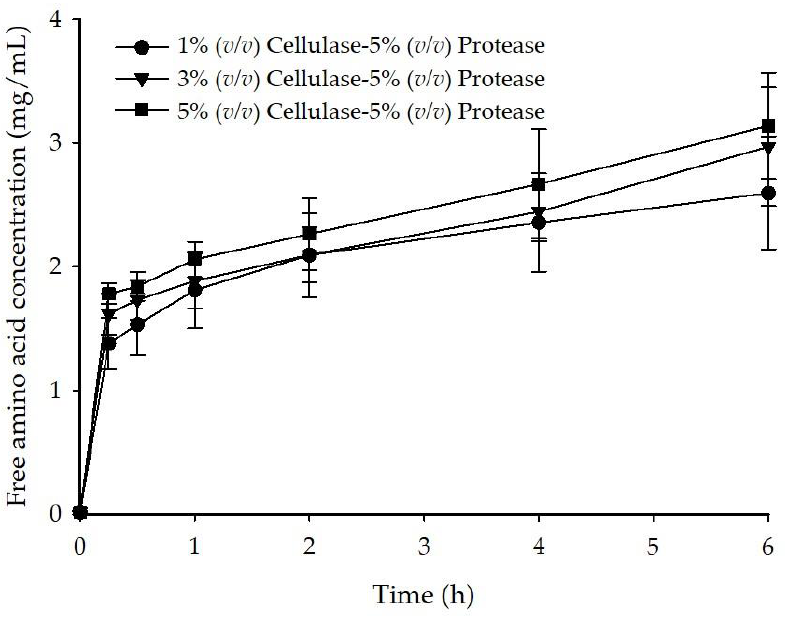
Figure 2. Time course of free amino group release during the enzymatic digestion of G. fisheri .